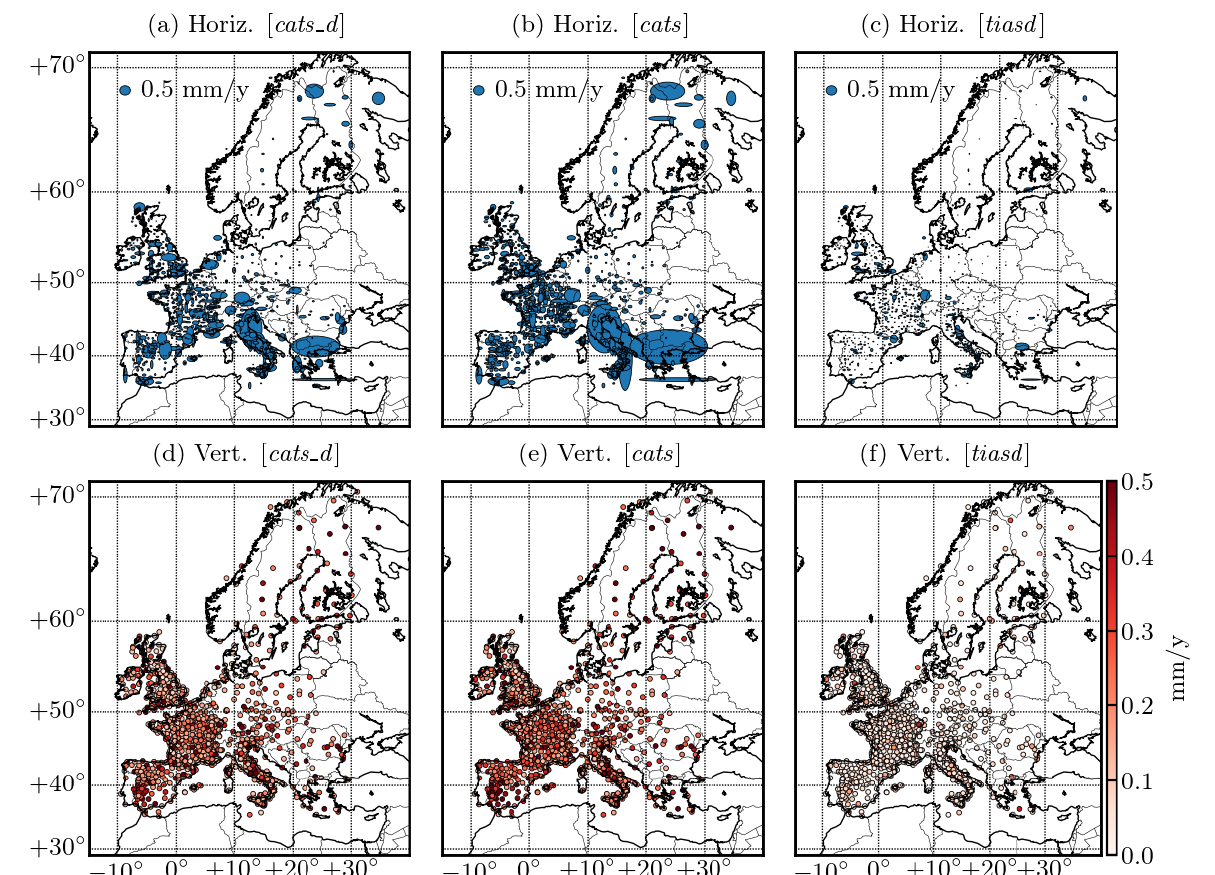
Figure 6. Uncertainty of ( a – c ) horizontal and ( d – f ) vertical velocity field for cats_d , cats , and tiasd